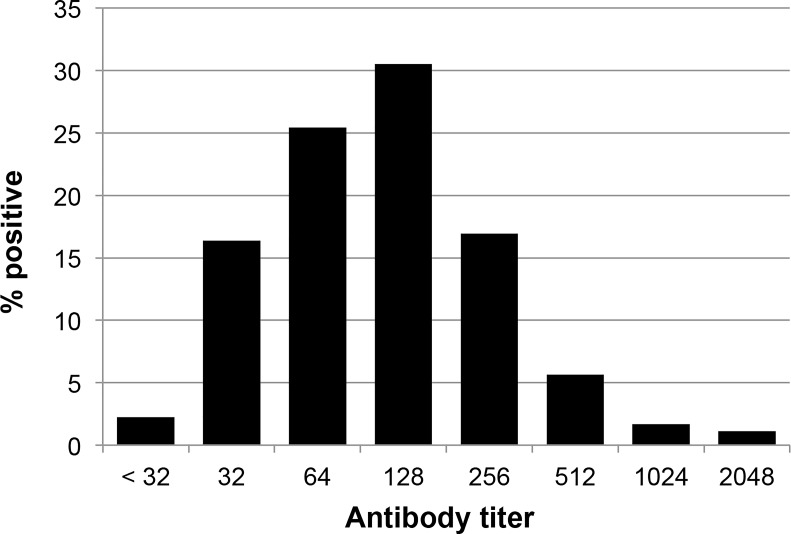
Distribution of B. bacilliformis antibodies by IFA assay among the study population (n = 177).